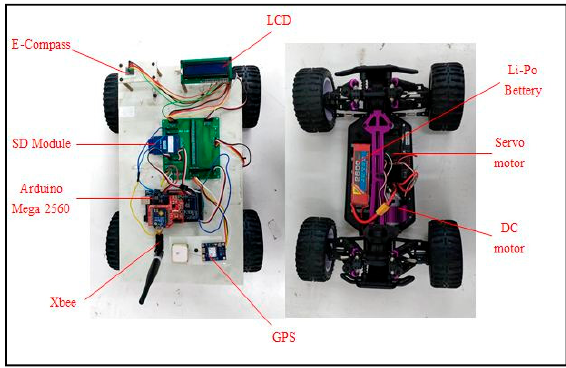
Figure 5. Experimental robot car.